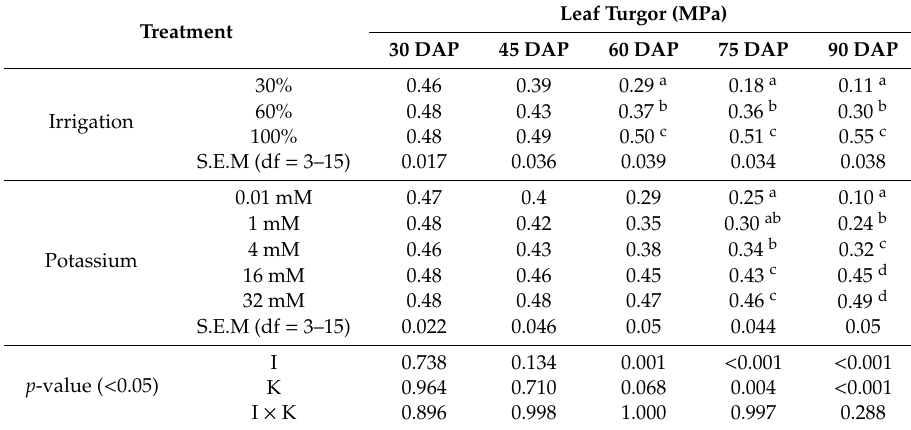
Table 1. Leaf turgor ( Ψ p ) of young cassava plants in response to deficit irrigation and K fertigation. The treatments were initiated 30 days after planting and lasted 60 days. The data from four separate experiments were combined and shown as the means ± standard error of 4–16 replicate plants.